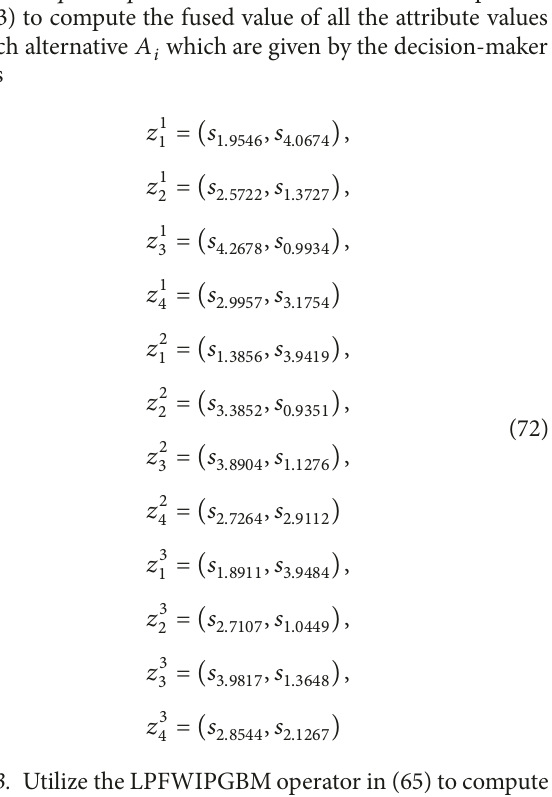
Table 6: The normalized linguistic Pythagorean fuzzy preference information matrix 𝑍 3 provided by the decision-maker 𝑀 3 . 𝐴 1 𝐴 2 𝐴 3 𝐴